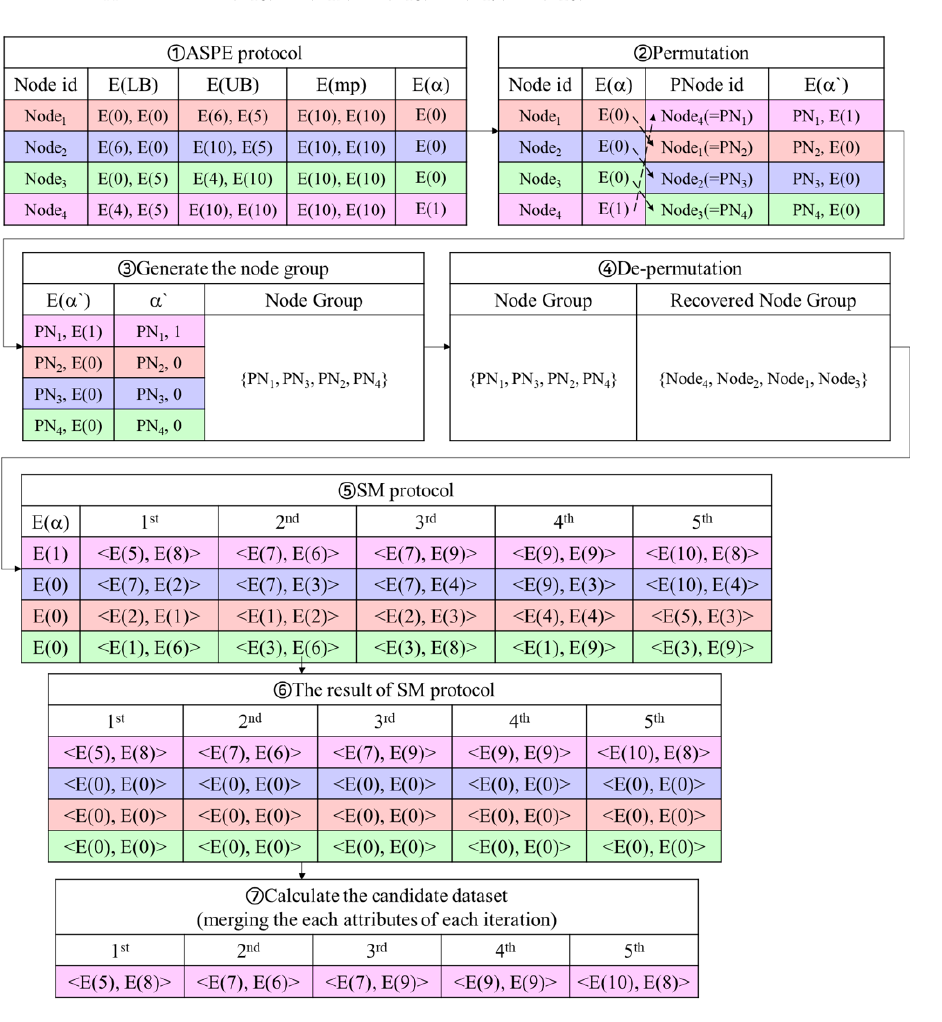
Figure 5. Example in node data search